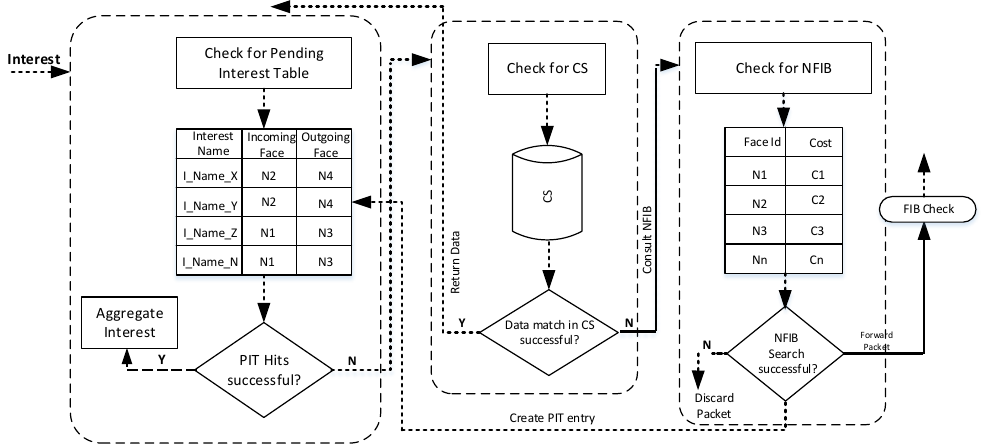
Figure 3. NFIB-based next-hop